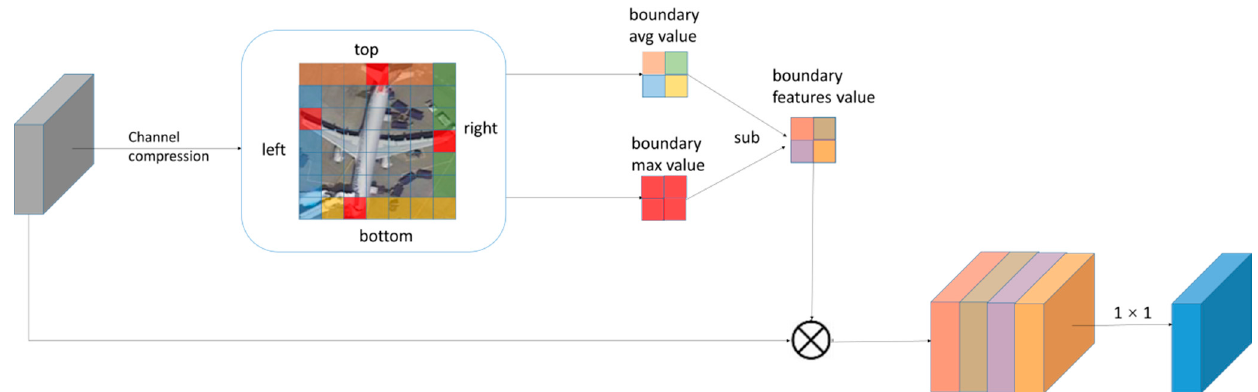
Figure 7. Boundary enhancement module.